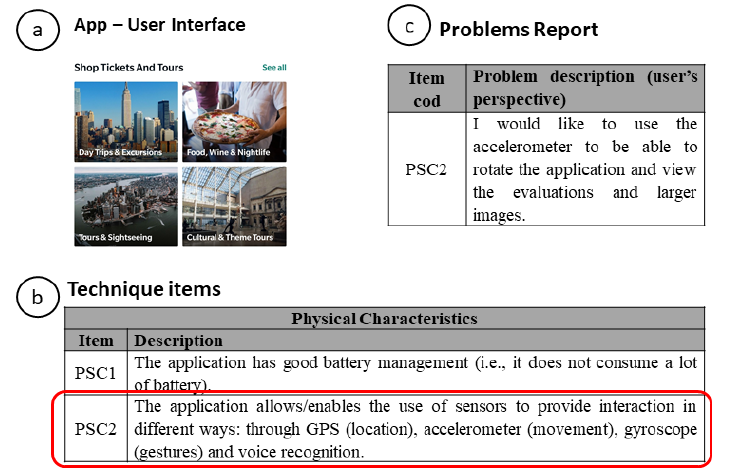
Figure 3. Process to report a problem with UX-Tips. ( a ) Using the app and identification problem step. ( b ) Using the technique to relate the problem and the evaluative item. ( c ) Describing the problem